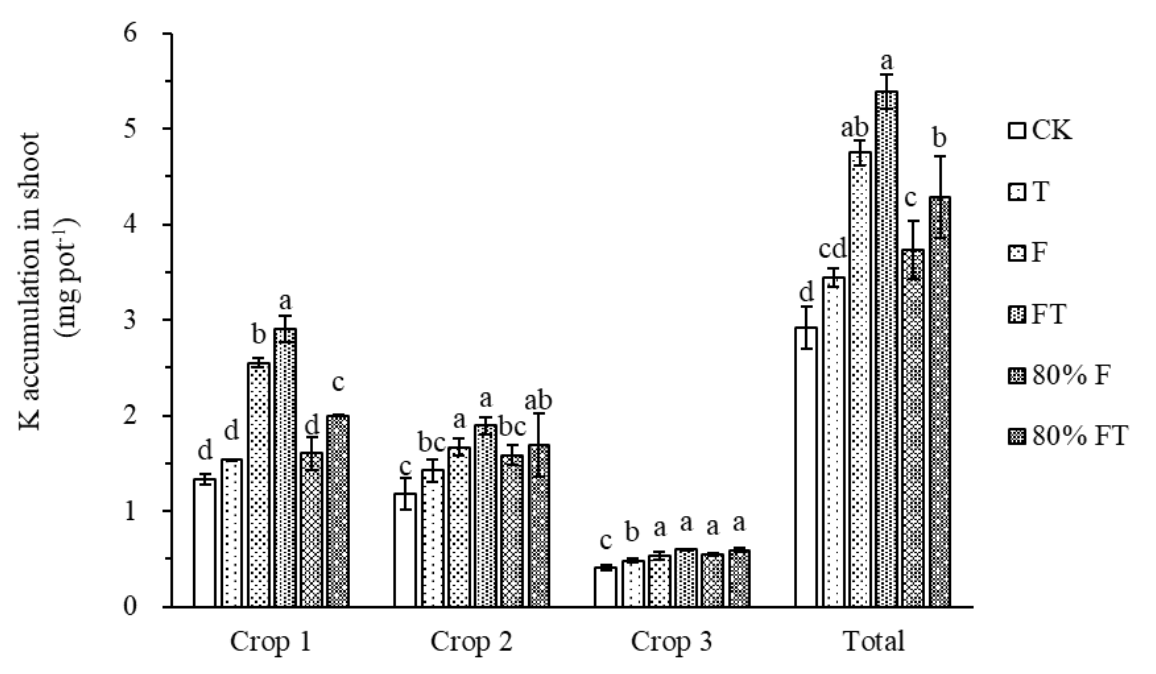
Figure 5. Effect of the preparation on potassium accumulation in the shoots. Values were expressed as means (n = 4) ± SE. Different letters within the same crop indicate significance at the 5% level.